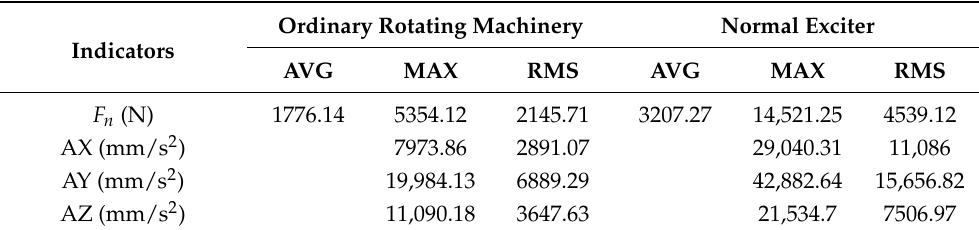
Table 2. Vibration response of helical gear pair of ordinary rotating machinery and normal excitation exciter.